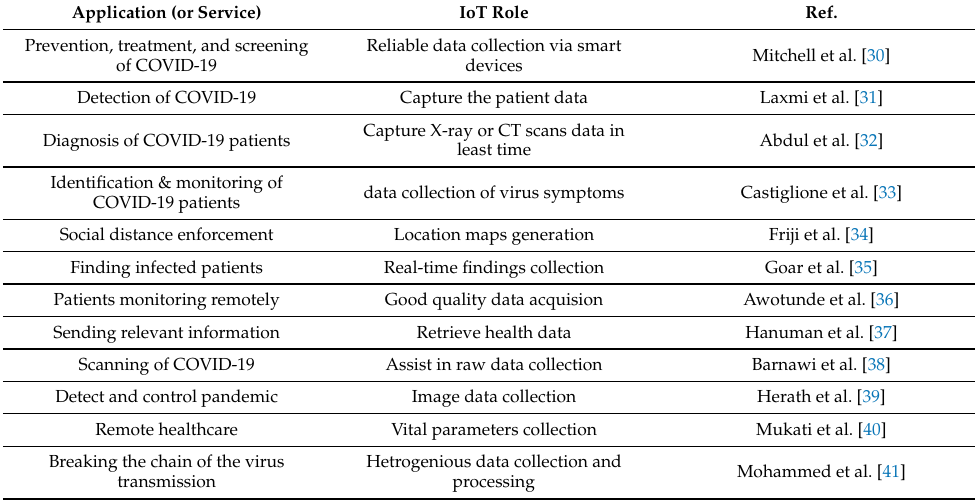
Table 2. Unique applications/services of IoT technology in the context of